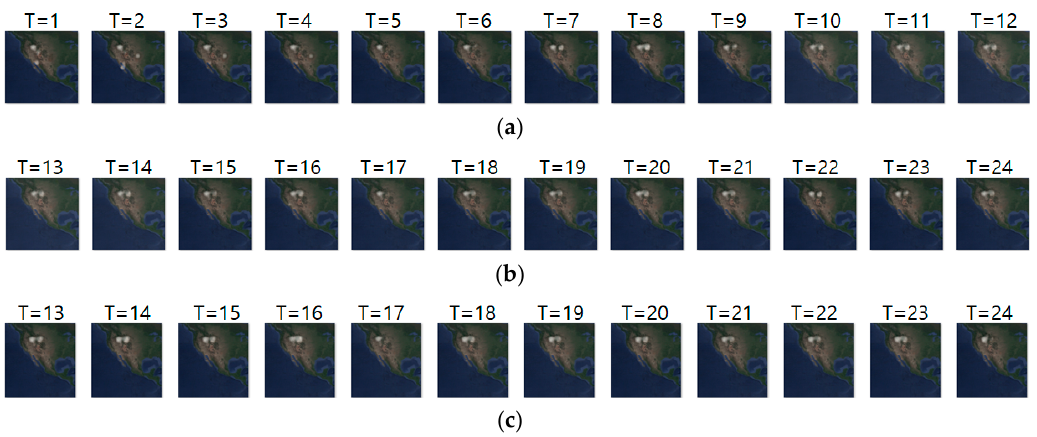
Figure 12. Movement prediction result–( a ) input sequence; ( b ) ground truth; ( c ) predicted sequence.